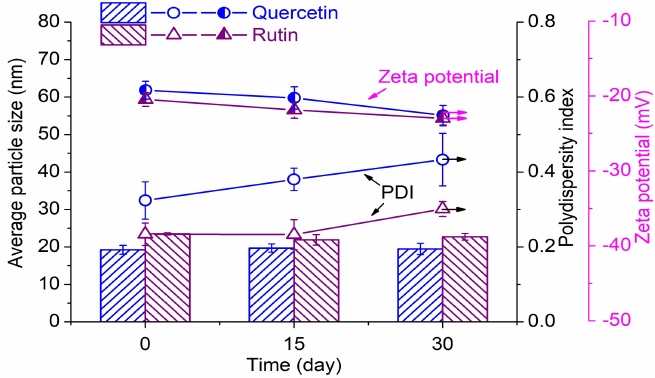
Figure 7. Changes in the particle size, polydispersity index, and zeta potential of AgNPs as a function of time.